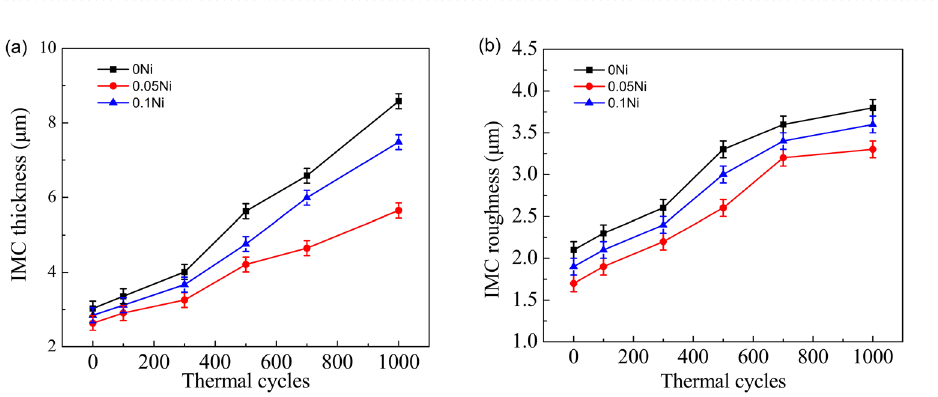
Figure 8. Top-view of IMC at the interface of Sn2.5Ag0.7Cu0.1RExNi/Cu after 500 thermal cycles: ( a ) 0 Ni, ( b ) 0.05 Ni, ( c ) 0.1 Ni.